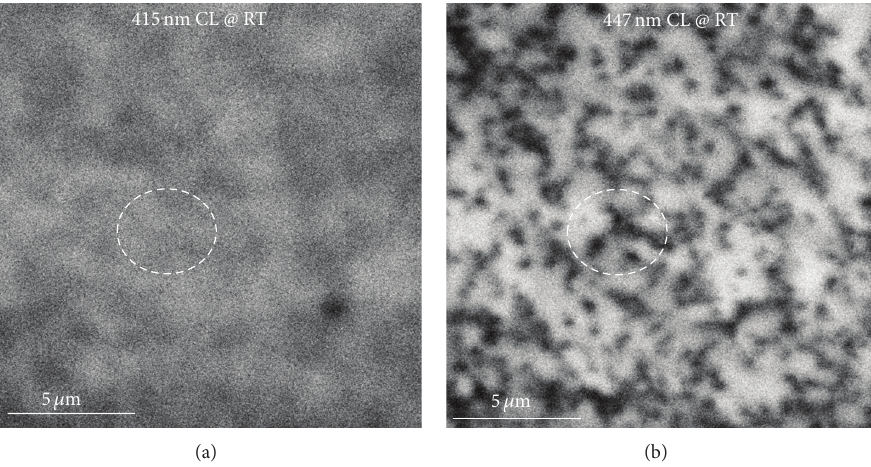
Figure 4: Observed mono-CL images which correspond to the high-energy and blue emission at room temperature. The dash circles show regions with a competition of the two emissions. The competition is not obvious at room temperature.